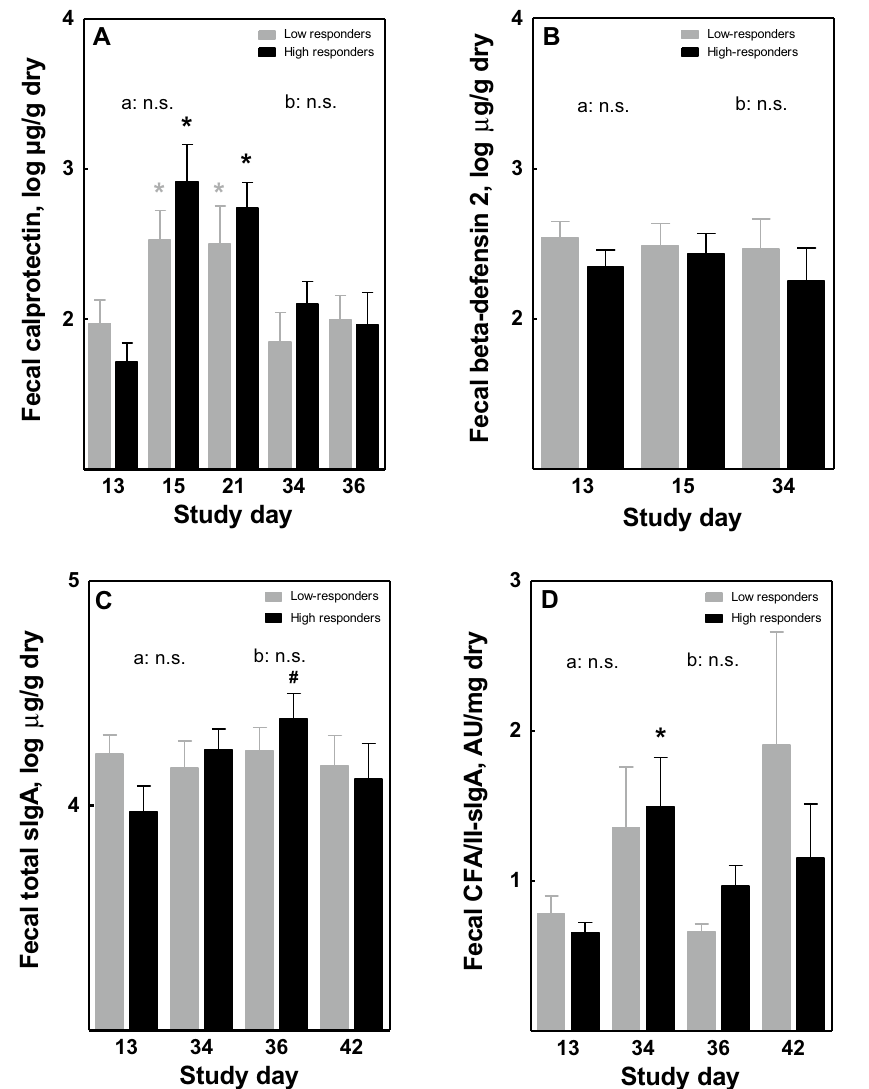
Figure 3. Effect of oral E. coli E1392/75-2A challenge on local fecal inflammatory and immune biomarkers. In fecal samples of high- and low-responders (n = 12 each), levels of calprotectin ( A ), β-defensin 2 ( B ), total sIgA ( C ) and fecal CFA/II-specific IgA ( D ) were analyzed. On day 14, subjects were orally infected with E. coli strain E1392/75-2A (dose 1E10 CFU or 5E10 CFU). On study day 35, all subjects received a second inoculation of 1E10 CFU of E. coli . Results are shown as means ± SEM. Timepoint at which significance is reached as compared to baseline day 13 (within the first infection period) or day 34 (within the second infection period) is indicated by *, with p < 0.05 within the specified group (repeated measures ANOVA; black *: within high-responders; grey *: within low-responders); # p < 0.05 at day 36 compared to baseline day 13. Significant differences in the overall response between high- and low-responders (two-way ANOVA) are indicated separately for the first ( a , days 13–34) and second ( b , days 34–42) infection period; ns not